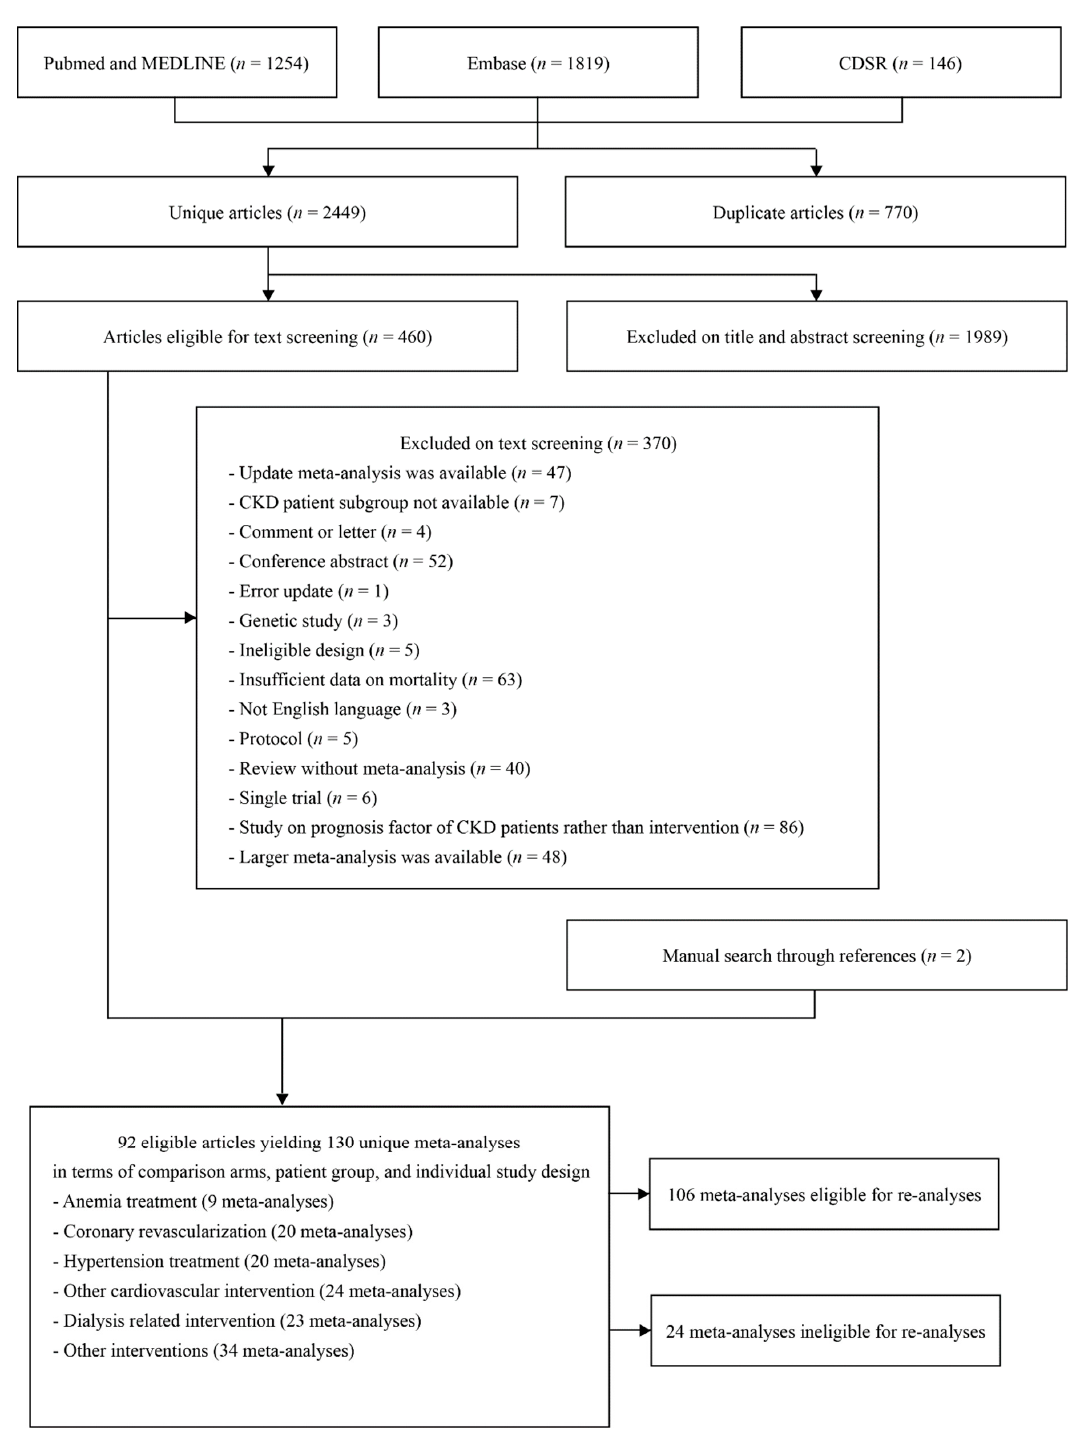
Figure 1. Flow chart of literature searches.